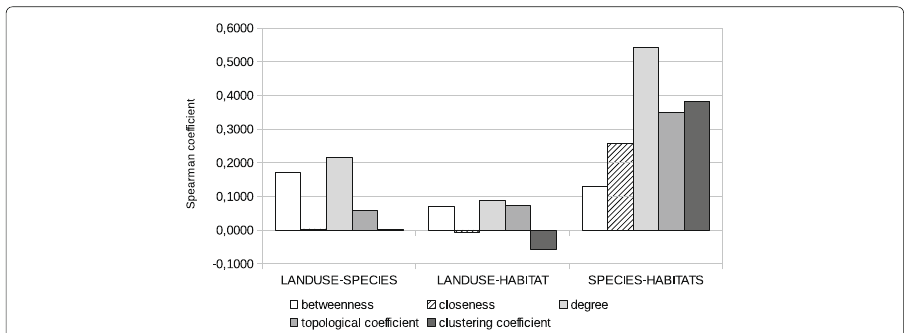
Fig. 3 Histogram representation of Spearman correlation of various complex network indices, between pairs of similarity-based graphs built using Jaccard